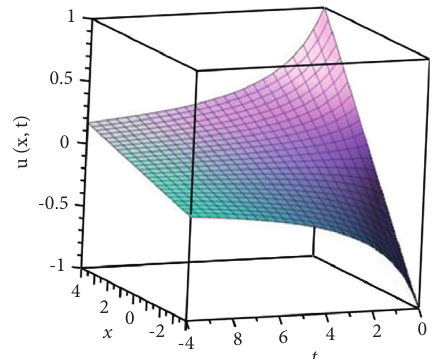
Figure 6: Plot of solution U